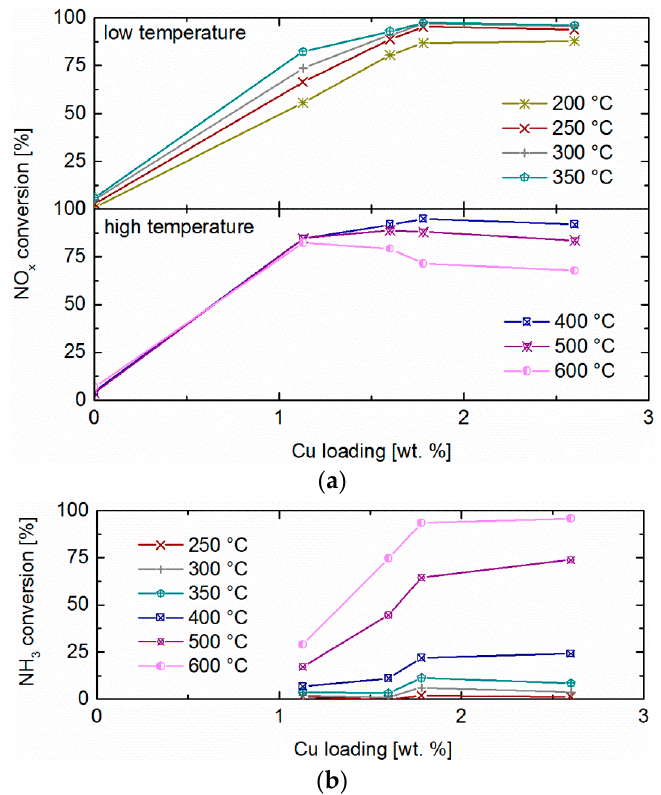
Figure 7. Steady state conversions in function of Cu loading. ( a ) NO x conversion during SCR; ( b ) NH 3 conversion during NH 3 oxidation.